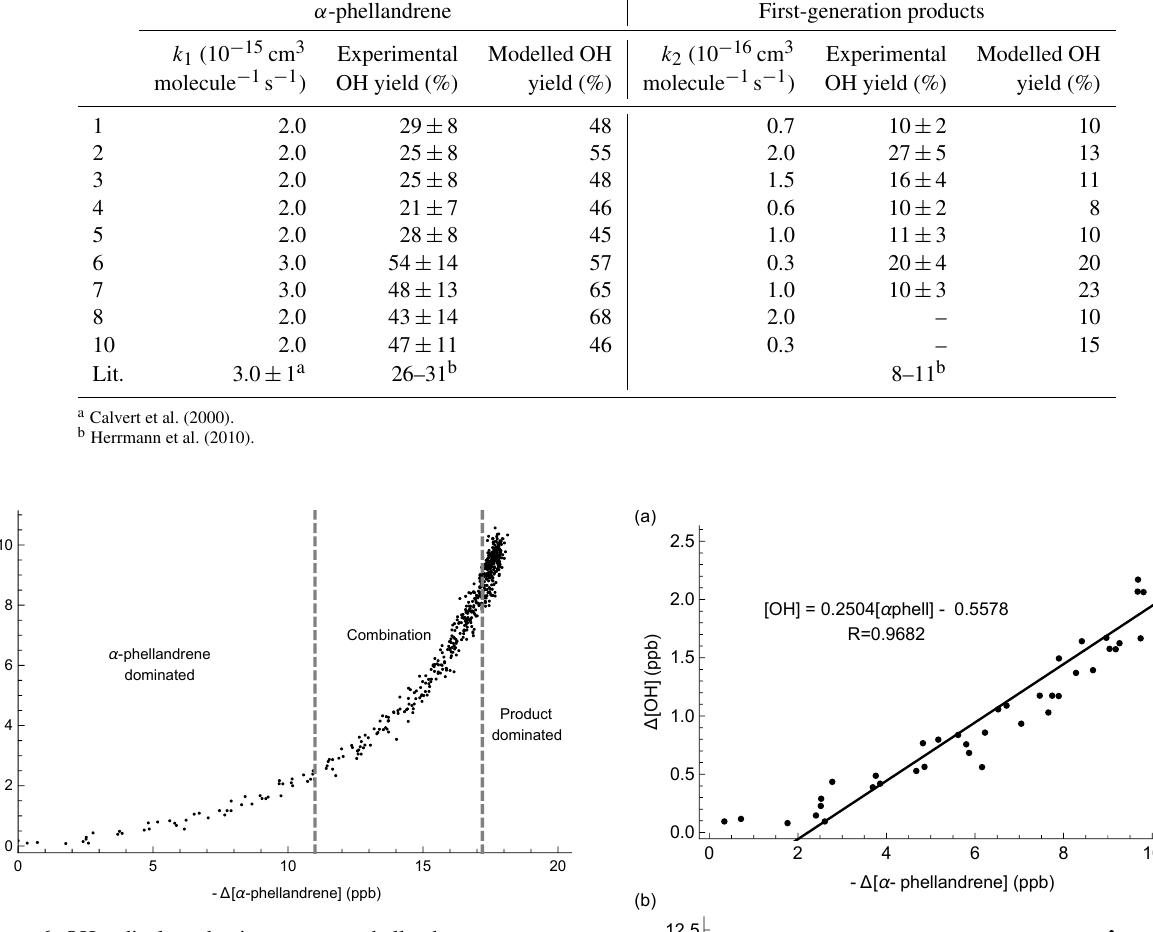
Figure 6. OH radical production versus α -phellandrene consump- tion for the first 18min of experiment 3.